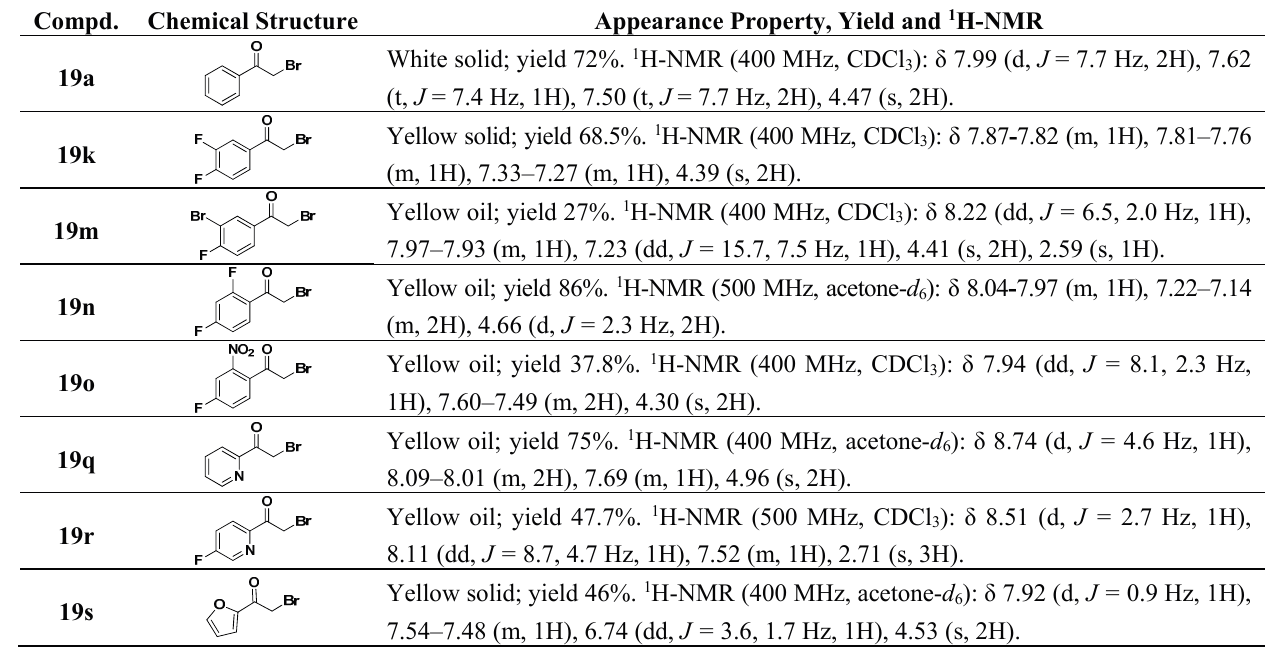
Table 4. The chemical structures, appearance, yields and 1 H-NMR of intermediates 19 .